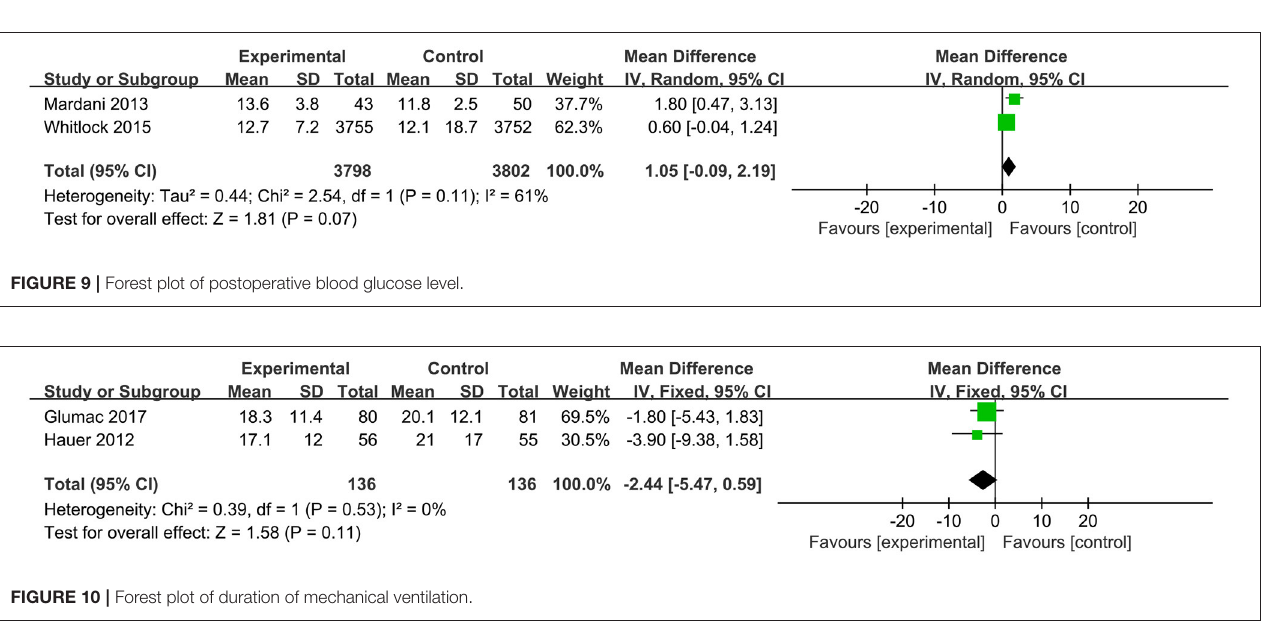
FIGURE 8 | Forest plot of postoperative injection.